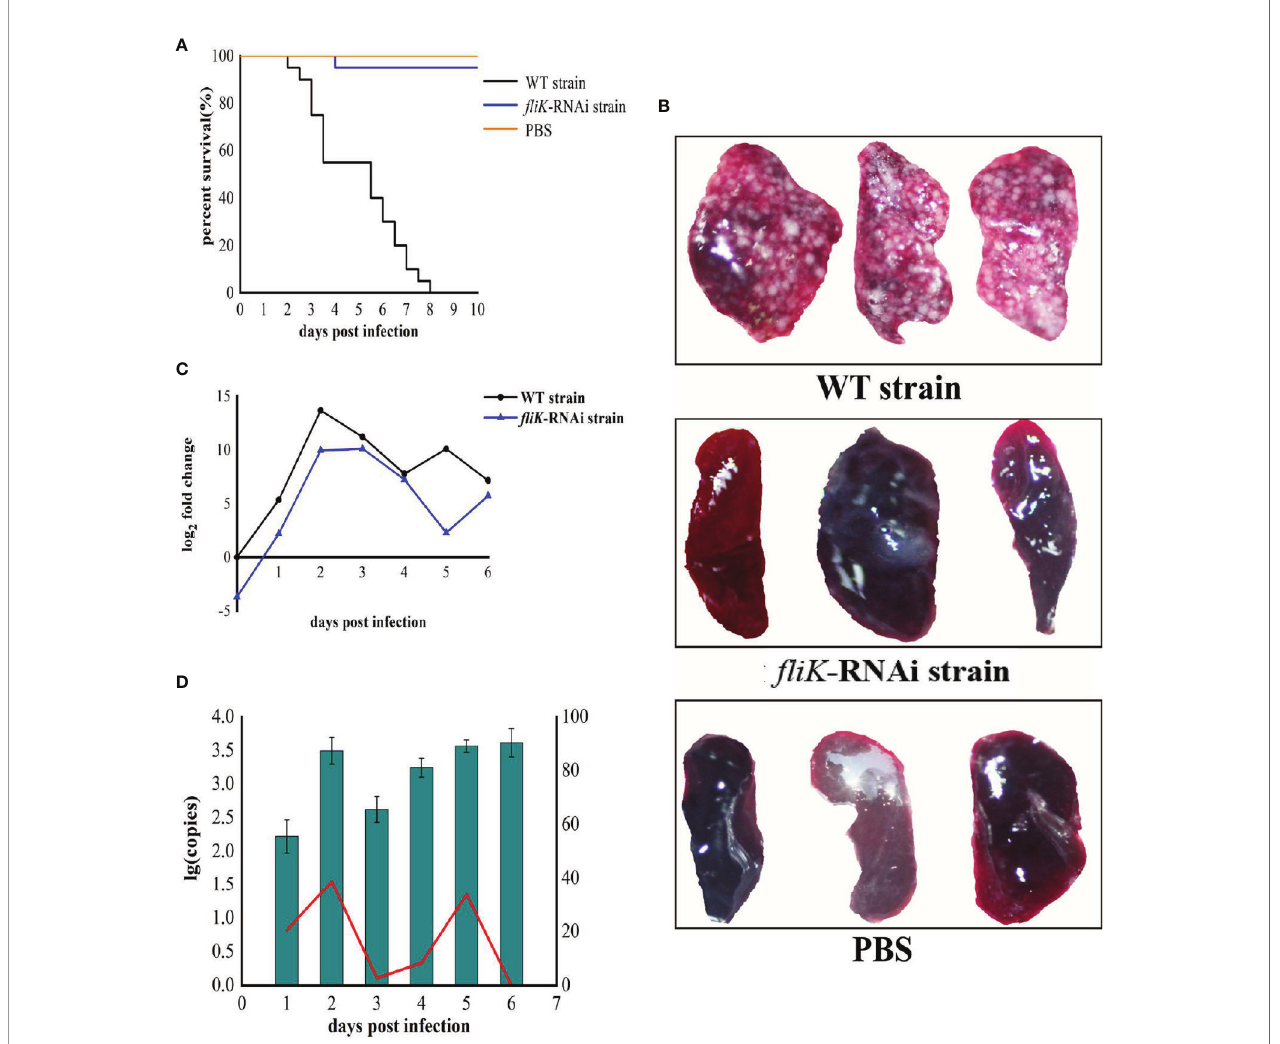
FIGURE 3 | Comparison of virulence between WT and fl iK -RNAi strains of P. plecoglossicida . (A) Survival rate of E. coioides post infection. (B) Symptoms in spleens of E. coioides injected with P. plecoglossicida or PBS. (C) Relative expression level of fl iK gene in P. plecoglossicida . (D) Pathogen load of P. plecoglossicida in spleens of E. coioides during infection. Bar chart represents pathogen load of fl iK -RNAi strain of P. plecoglossicida , represented by copy number of gyrB gene. Line graph represents relative pathogen load of fl iK -RNAi strain to WT strain, represented by copy number of gyrB gene of fl iK -RNAi strain/copy number of gyrB gene of WT strain ×